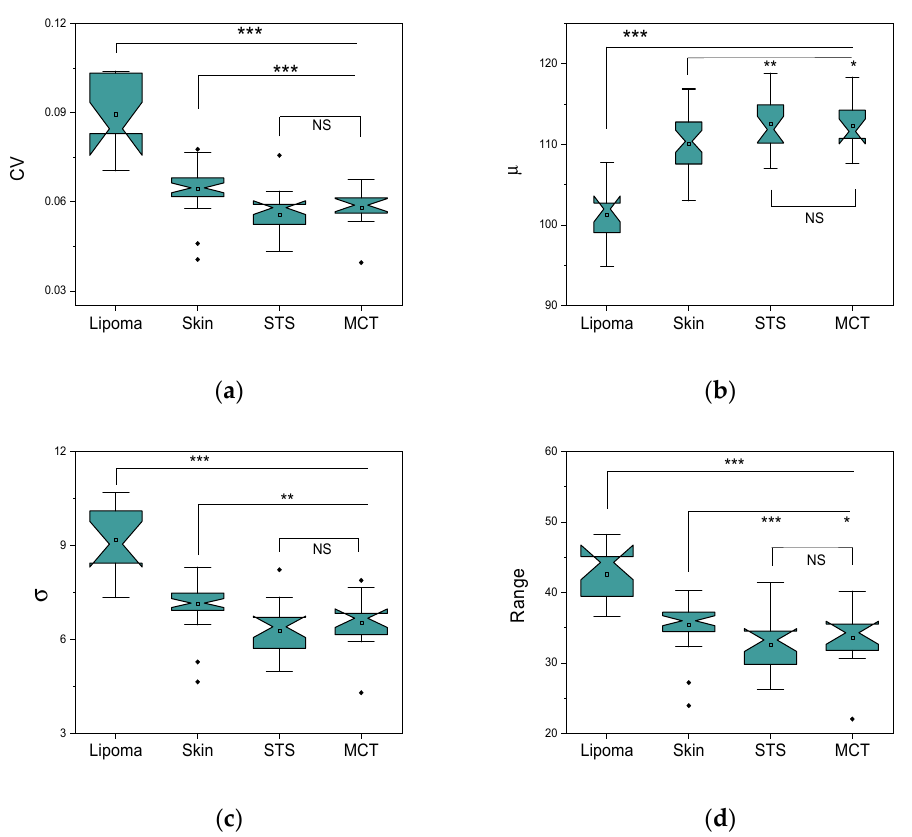
Figure 5. Boxplots of tissue OCT features; ( a ) coefficient of variation (CV), ( b ) intensity mean ( μ ), ( c ) standard deviation ( σ ), and ( d ) intensity range. The central mark represents the median; the bottom and top box edges indicate the 25th and 75th percentiles, respectively. Whiskers extend to the most extreme data point. The outliers are marked as dots. Respectively, p—values less than 0.05, 0.01, 0.001 are shown by *, **, *** (Mann—Whitney).